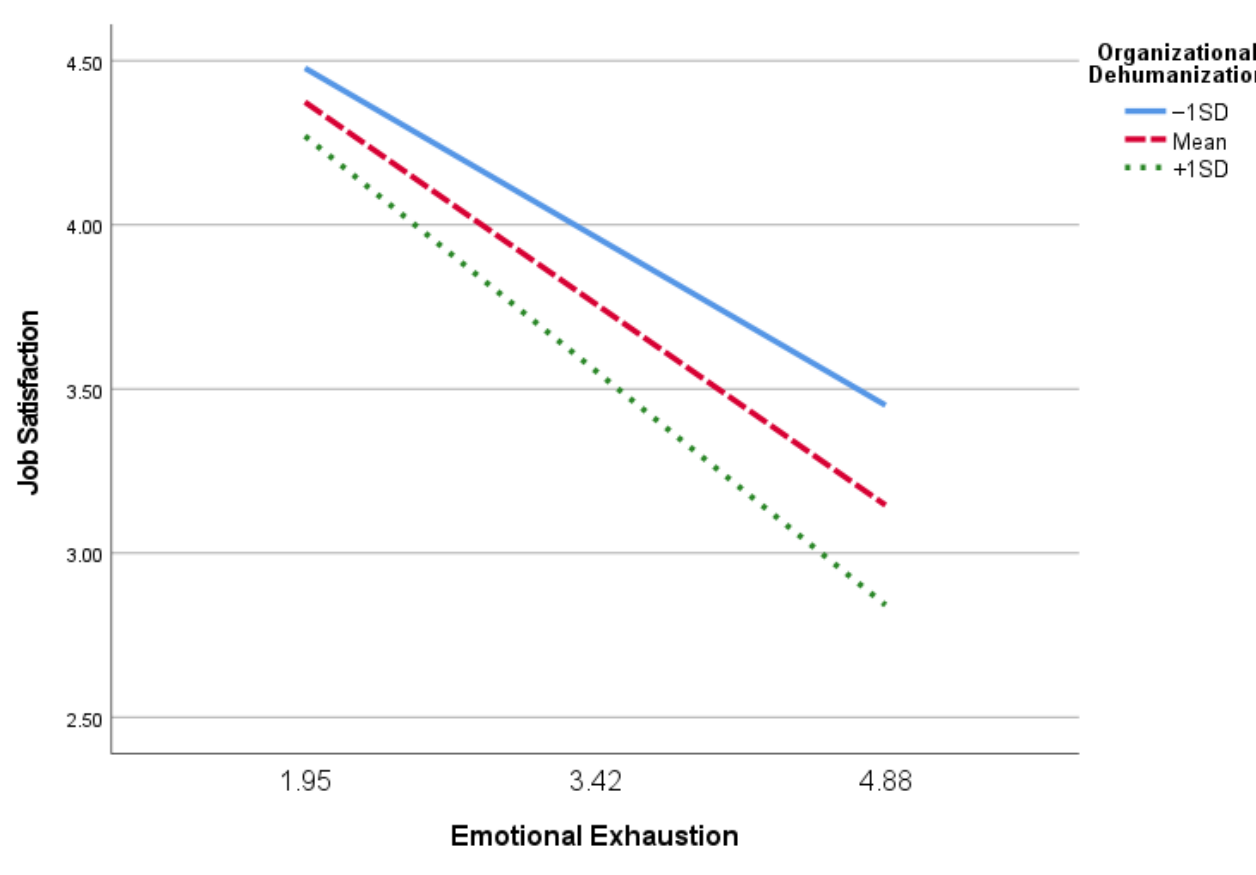
Figure 2. Moderation effect of organizational dehumanization on the link between emotional exhaus- tion and job satisfaction.